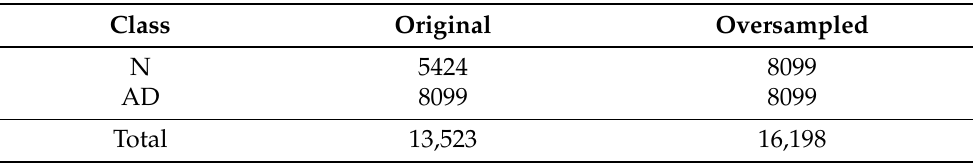
Table 2. Number of data windows before and after oversampling (example for windows of 512 samples with 25%